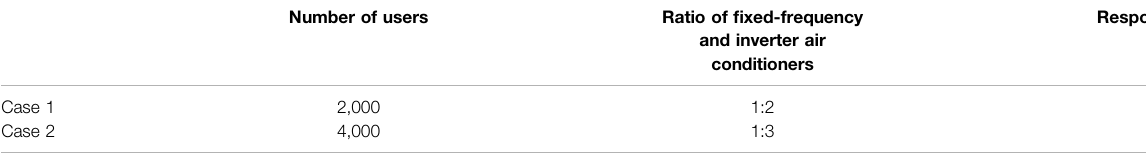
TABLE 3 | Cases set for analysis and discussion.